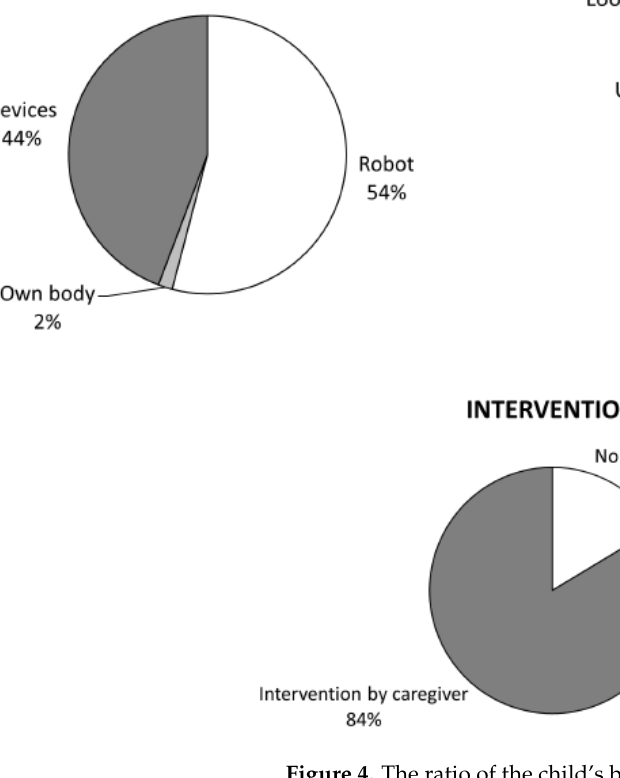
Figure 4. The ratio of the child’s behaviors and the parent’s intervention during the disengagement (total 61